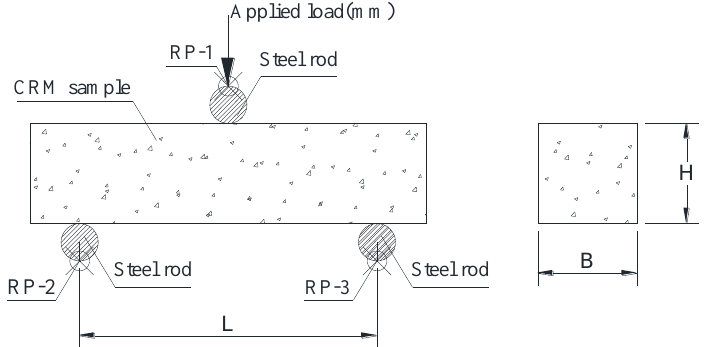
Figure 11. Schematic diagram of CRM specimen three-point flexural test.